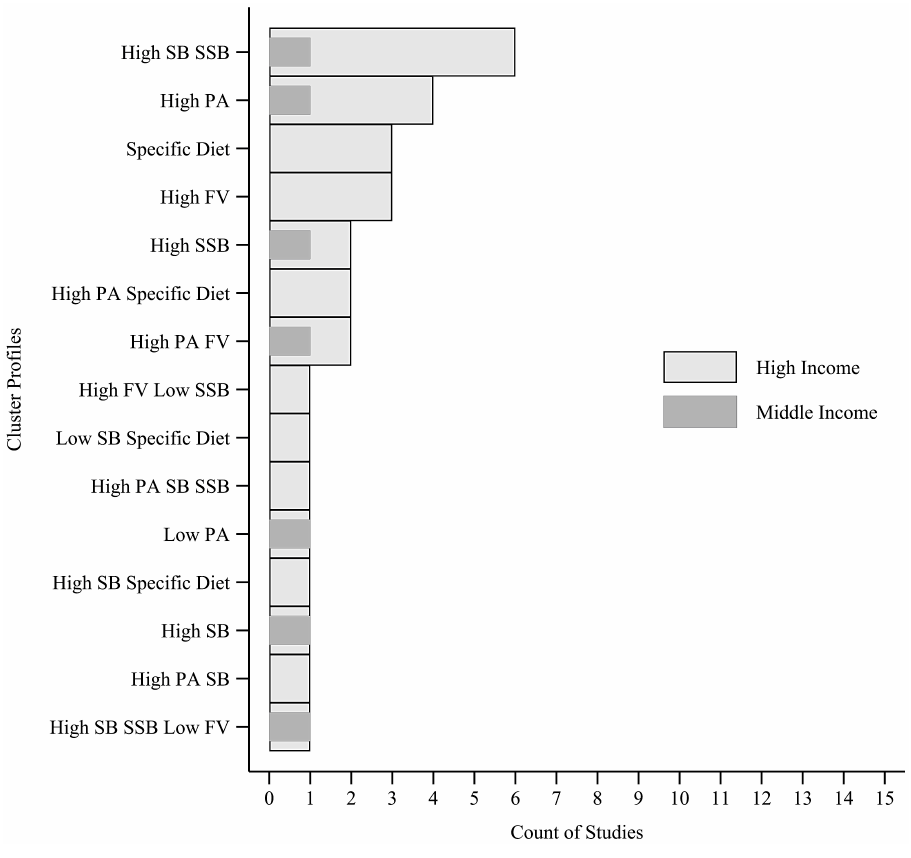
Figure 5. Characteristics of clustering patterns of obesogenic behaviors applying factors procedures (principal component analysis, factorial analysis and multiple corresponding analysis) across studies. F&V: fruits and vegetables; SSB: sugar-sweetened beverages; SB: sedentary behavior; PA: physical activity. Country income classified by The World Bank (https://datahelpdesk.worldbank.org/, accessed at 7 July 2021) according to year of data collected of each